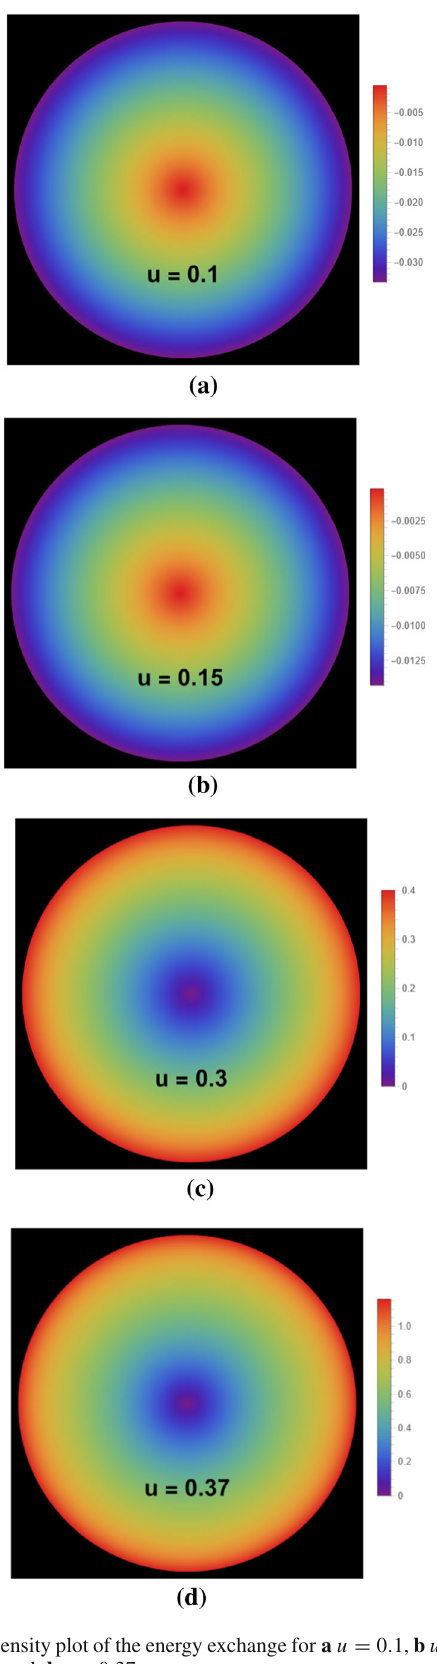
Fig. 8 Density plot of the energy exchange for a u = 0 . 1, b u = 0 . 15, c u = 0 . 3 and d u = 0 . 37